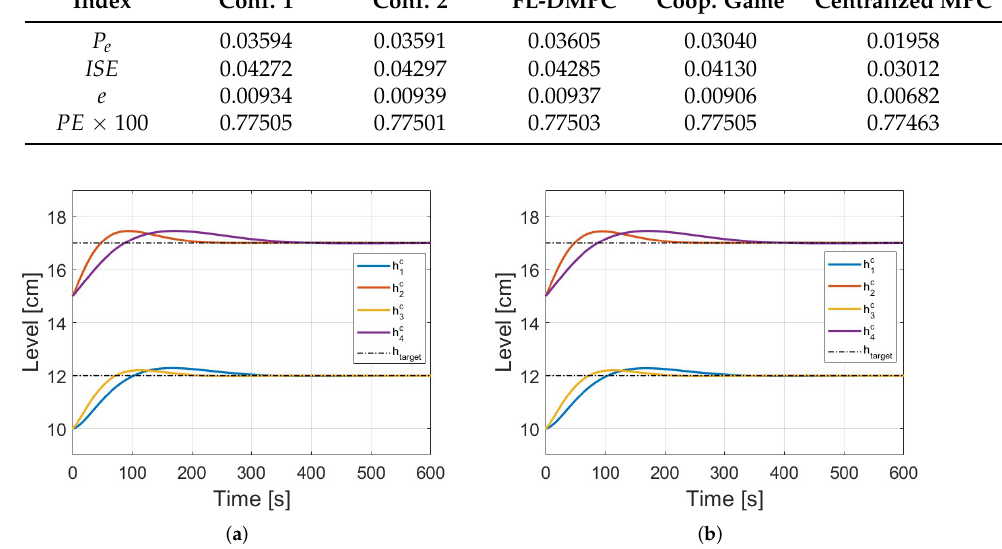
Figure 6. Validation Case 1: Evolution of the levels of the controlled variables: ( a ) Conf. 1 performance; ( b ) Conf. 2